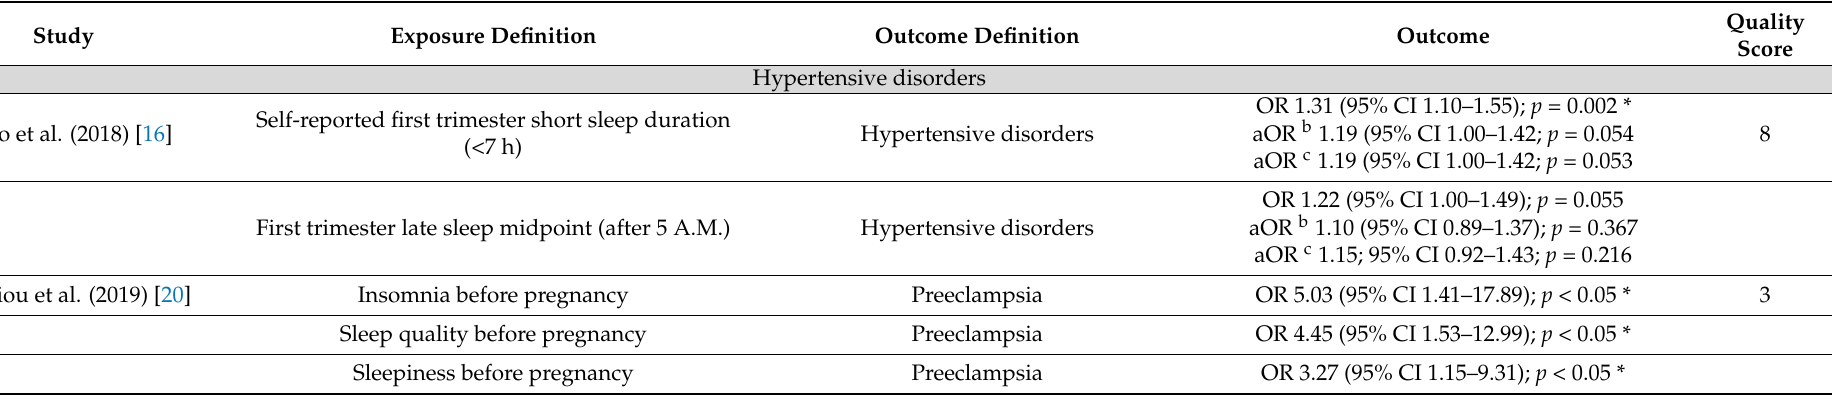
Table 2. Overview of maternal outcomes of included studies in the systematic review (N =